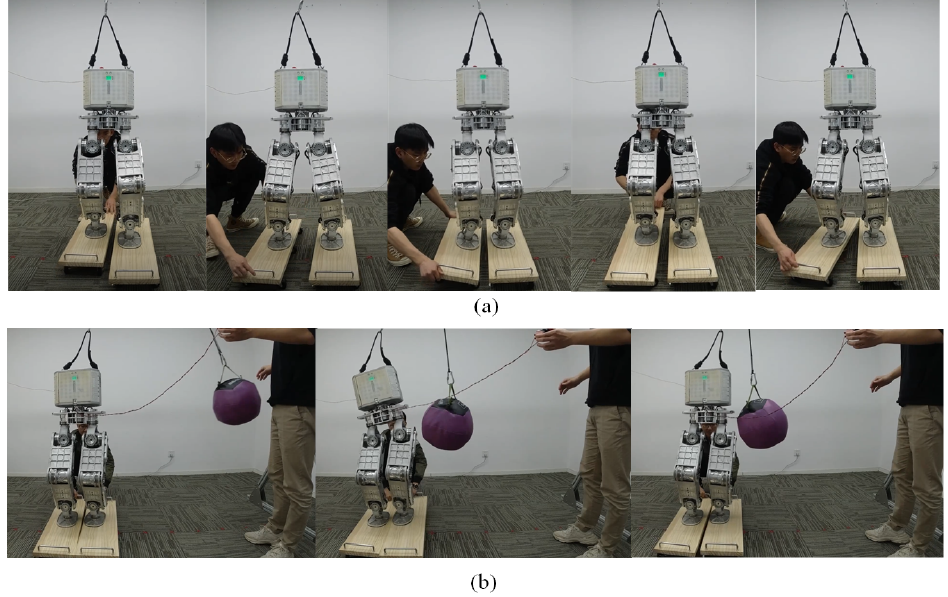
Figure 12. The balancing behaviors when the right support moves in all directions ( a ) and the balancing behaviors in push recovery on the moving support scenario ( b ).